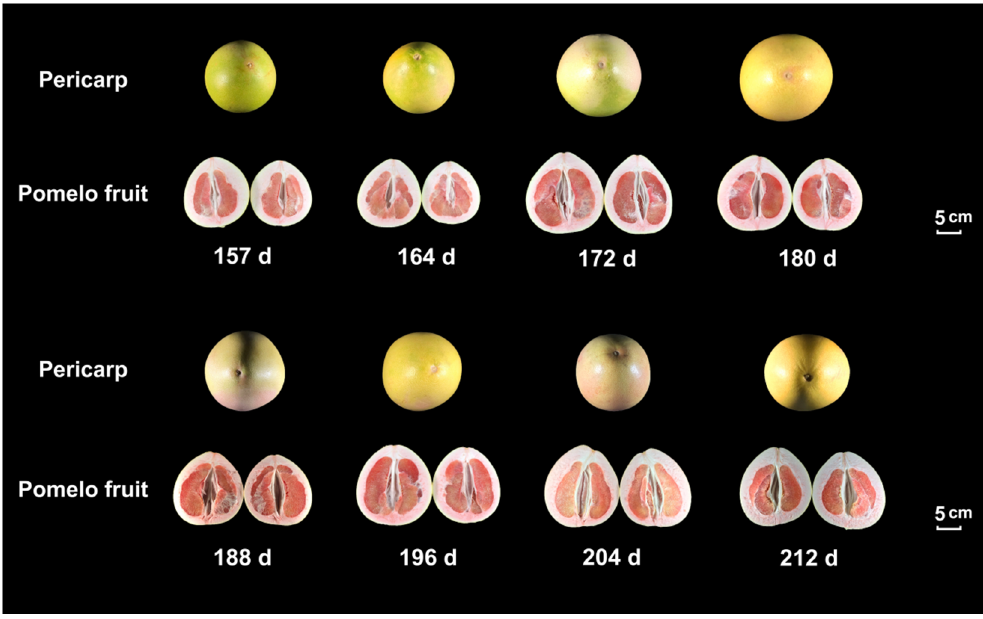
Figure 1. The exterior and interior characteristics of pomelo fruits at different developmental stages. Fruit samples were picked at 157, 164, 172, 180, 188, 196, 204, and 212 days post anthesis (DPA).